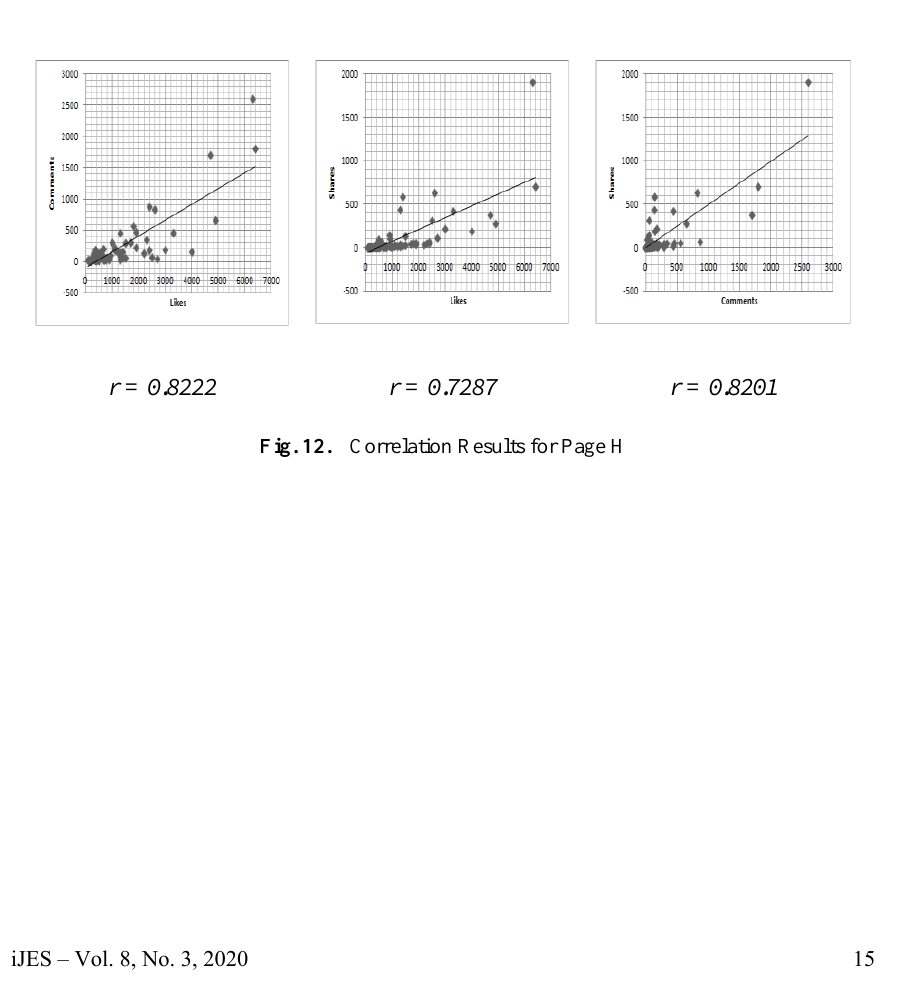
Fig. 11. Correlation Results for Page E